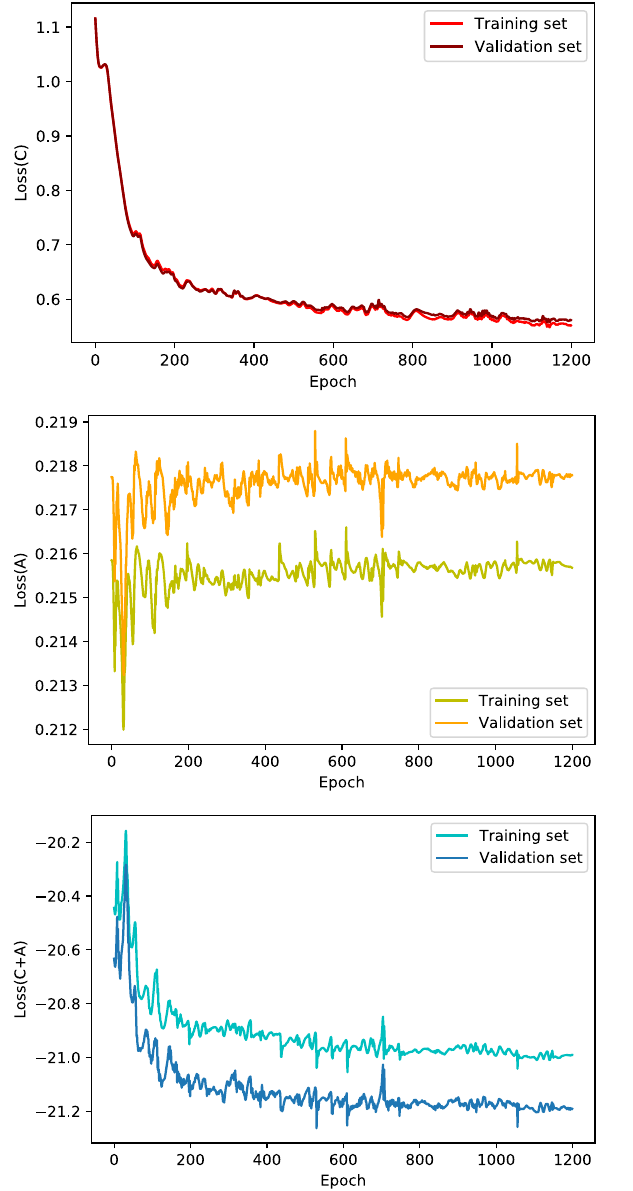
Fig. 2 Loss function of the classifier (top), adversary (middle) and combined loss function (bottom) of the ADNN trained in C1